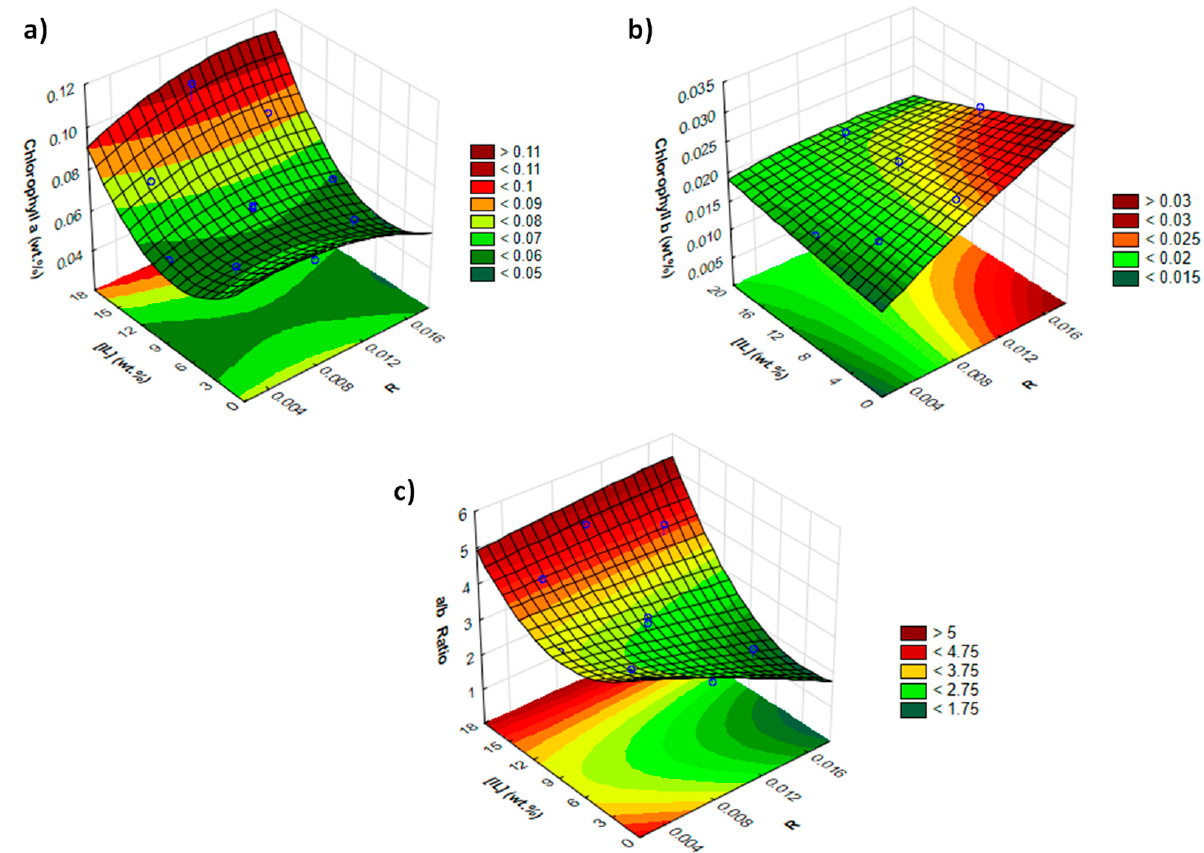
Figure 4. Response surface with combined effects of solid–liquid ratio (R) and [C 16 py]Cl concentration ([IL] wt.%) on the ( a ) extraction yield of chlorophyll a (wt.%); ( b ) extraction yield of chlorophyll b (wt.%); and ( c ) chlorophyll a / b ratio.